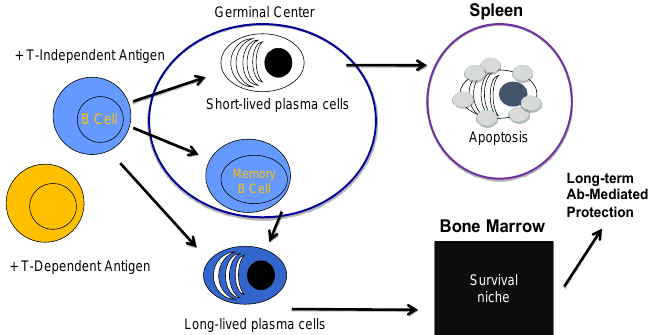
Figure 1. Model of B to plasma cell (PC) differentiation. Upon activation with antigen in a T cell independent (above) or dependent (below) manner, B cells can differentiate into antibody-secreting plasma cells that either reside in secondary lymphoid organs such as the spleen, where they primarily secrete IgM and live for days to weeks before dying by apoptosis. B cells can also differentiate into memory B cells, which, upon reactivation with the antigen, can differentiate into plasma cells. In a second non-mutually exclusive model, B cells can differentiate into long-lived plasma cells that are home to the bone marrow where they occupy special survival niches and provide durable humoral immunity through the long-term production of antigen specific antibodies, primarily IgG.